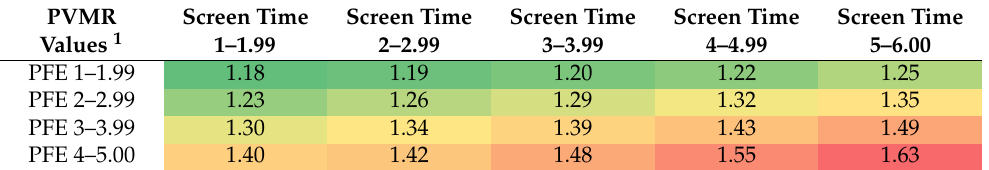
1 Green color = small values; yellow color = medium values; red color = large